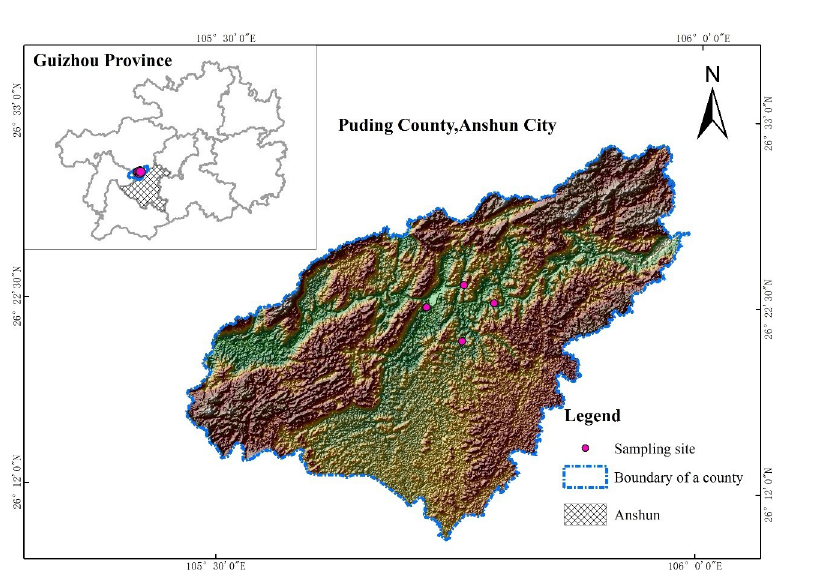
Fig 1. A map of the study area and sampling plot.